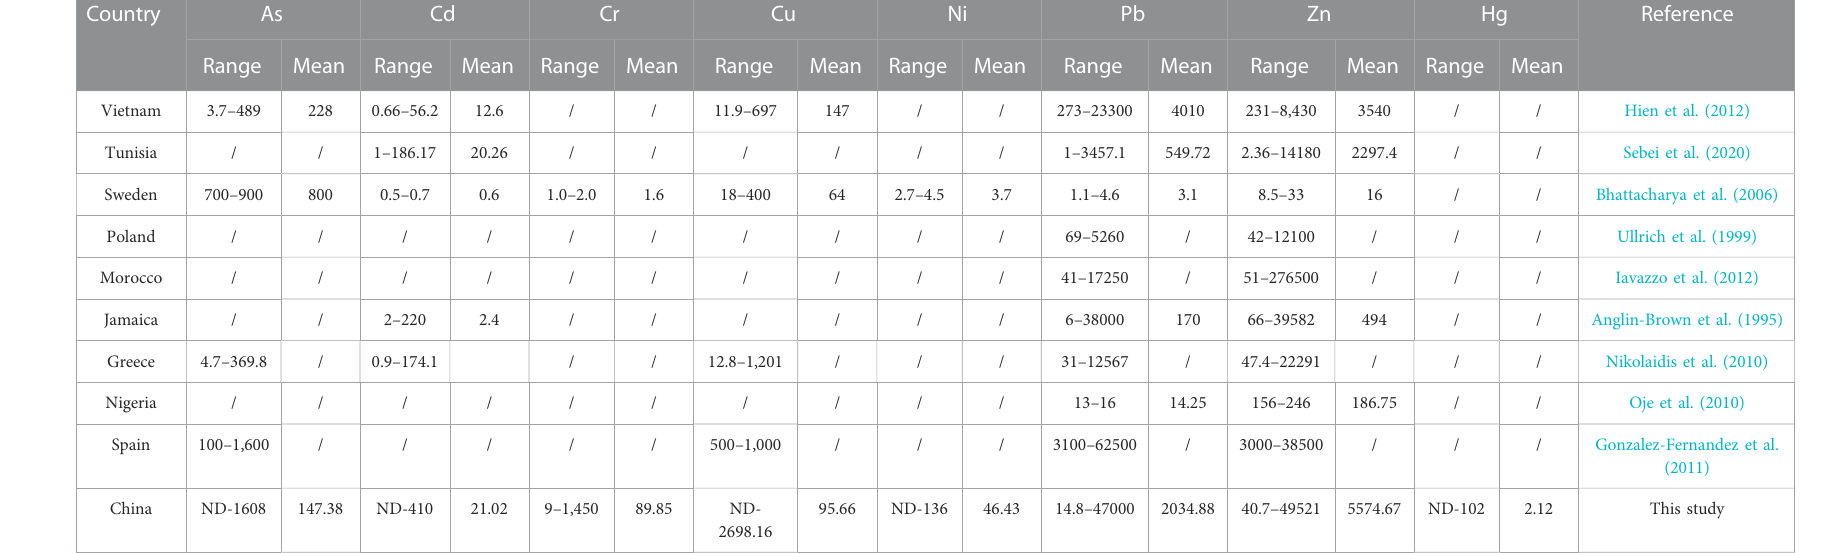
TABLE 3 Concentrations of heavy metals in soils in the vicinity of lead – zinc mining areas in other countries and regions (mg/kg). Country